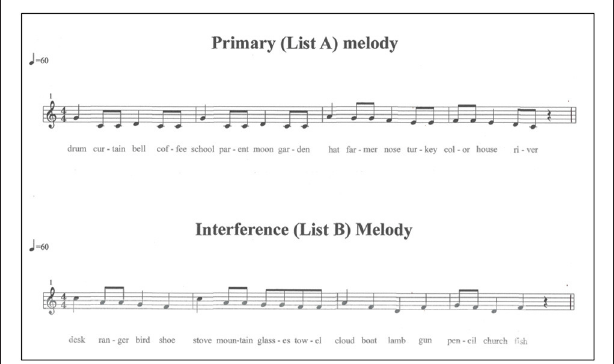
FIGURE A1 | Primary and interference lists music notation. Words, melodic and rhythmic notation used in Primary and Interference